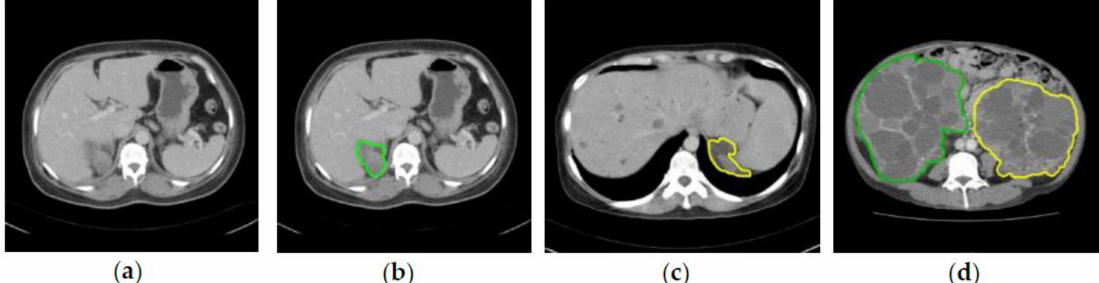
Figure 2. CCT raw image and respective ground truth images: ( a ) Raw image; ( b ) Ground truth for right kidney (Green); ( c ) Ground truth for left kidney (Yellow); ( d ) Ground truth for both right (Green) and left (Yellow) kidneys.